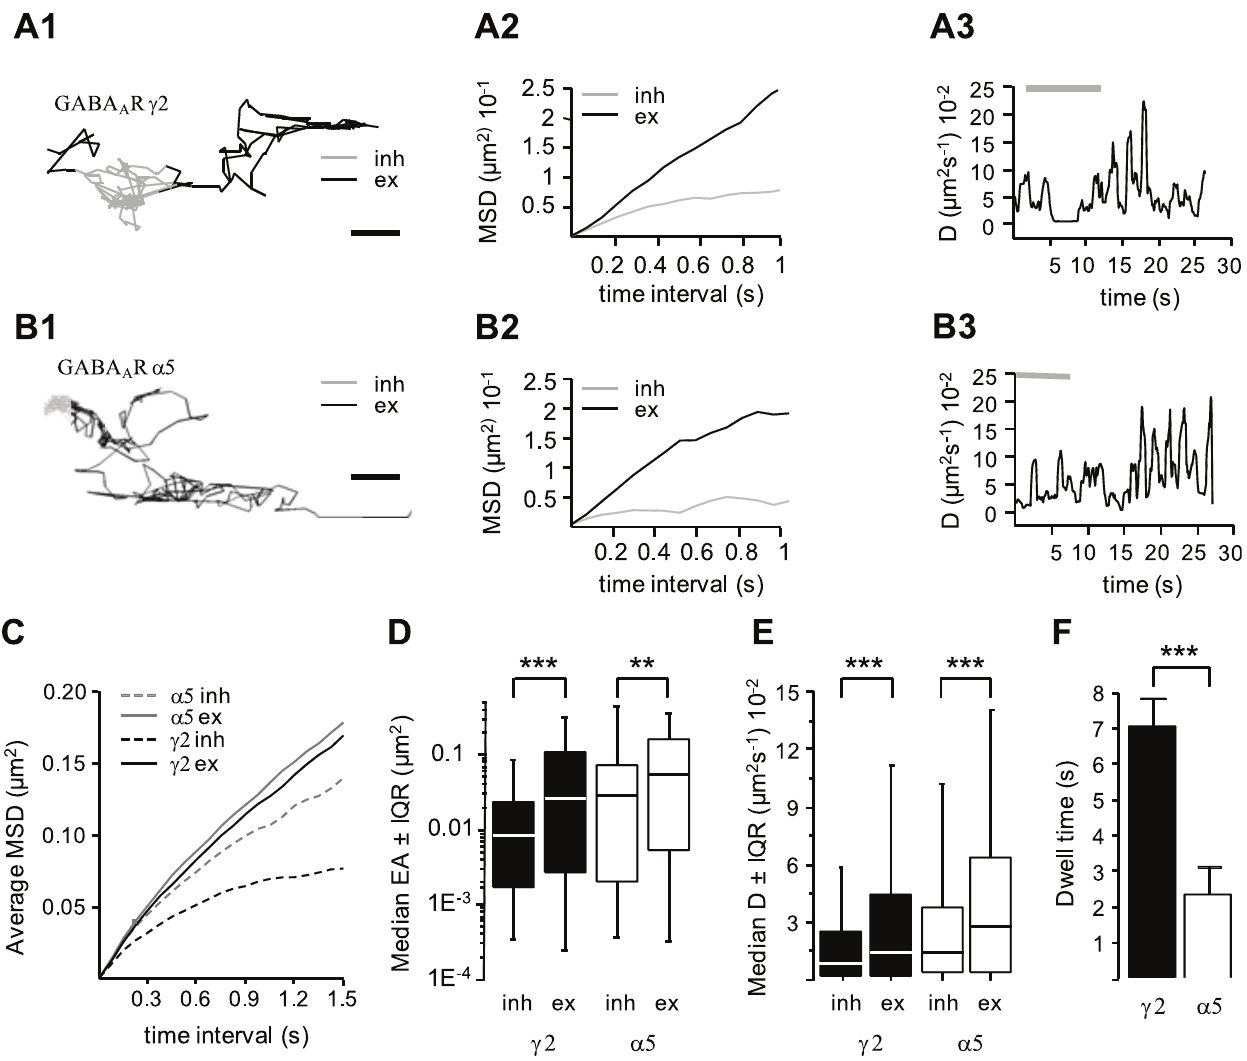
Figure 1. Membrane dynamics of the GABA A R c 2 and a 5 subunits in relation with inhibitory synapses. (A, B) Examples of individual trajectories of QDs coupled to c 2 (A1) and a 5 (B1) outside (black) or inside (grey) inhibitory synapses and their corresponding MSD (A2, B2) and instantaneous diffusion coefficients as a function of time (A3,B3). Scale, 0.5 m m (A1) and 1 m m (B1). Note the reduced diffusion and increased confinement of c 2 and a 5 in inhibitory synapses vs . extrasynaptic membrane. (C–E) Diffusion behavior of receptor populations analyzed from pooled QD trajectories. Averaged MSD vs . time function (C), explored surface area (D, (median EA 6 25%–75% Interquartile Range IQR; KS test ***p , 10 2 3 , **p , 10 2 2 ), diffusion coefficient (E, median D 6 25%–75% IQR; KS test ***p , 10 2 3 ) of c 2 (black) and a 5 (white) trajectories in inhibitory synapses (inh) and in extrasynaptic compartments (ex). (F) Dwell time (mean 6 SEM) of the indicated receptors at inhibitory synapses (t-test, ***p , 10 2 3 ).